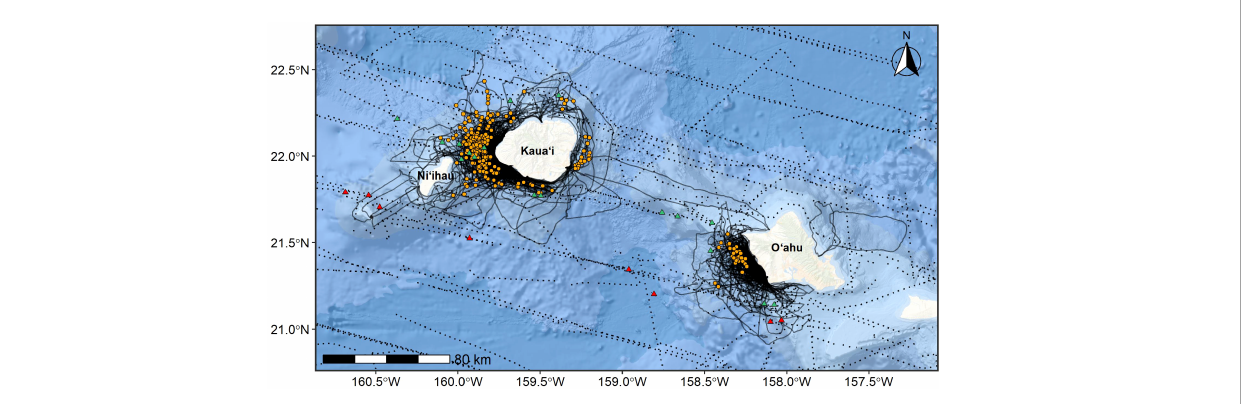
FIGURE 3 Rough-toothed dolphin sighting locations (orange circles = CRC, green triangles = NMFS) off Kaua ʻ i and Ni ʻ ihau (n=274) and O ʻ ahu (n=38) overlaid on CRC small boat survey research vessel tracklines (solid lines) from efforts conducted during 2002-2021 (33,850 km of effort; solid lines) and NMFS ship- based line-transect surveys (dotted lines) conducted during 2002-2020 (7,238 km of effort in the area mapped here; dotted lines). Red NMFS sighting locations (n=8) indicate sightings where population assignment is currently unknown and/or sightings are outside the known range of the insular population. Basemap image is the intellectual property of Esri and is used herein with permission. Copyright © 2022 Esri and its licensors. All rights reserved.